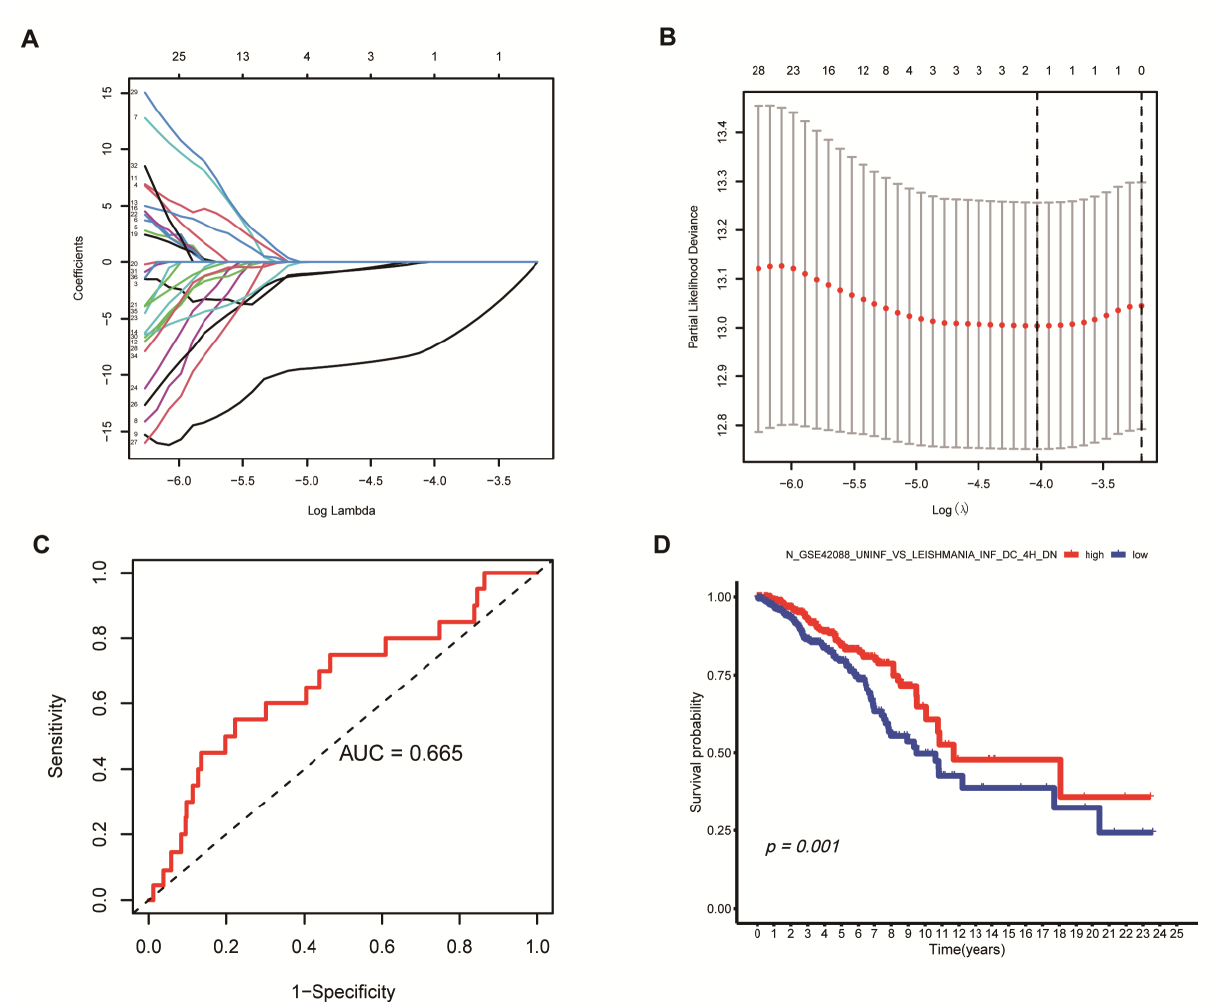
Figure 5. Potential prognostic gene sets in BC ( A ) The most prognostic gene sets were identified by the LASSO algorithm. ( B ) 10 rounds of cross validation were performed to prevent overfitting. ( C ) The ROC curve analysis of gene sets N_GSE42088. ( D ) Kaplan–Meier survival curves of N_GSE42088 gene set.